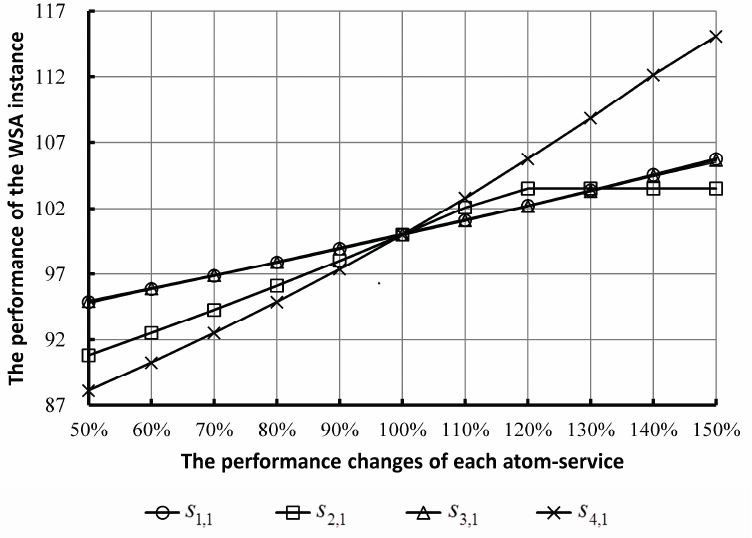
Figure 9. The performance influence on the SCA instance by the performance changes of each atom-service.